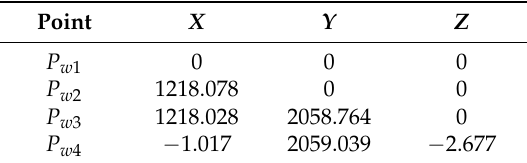
Table 1. Coordinates of the featured points on the roof.